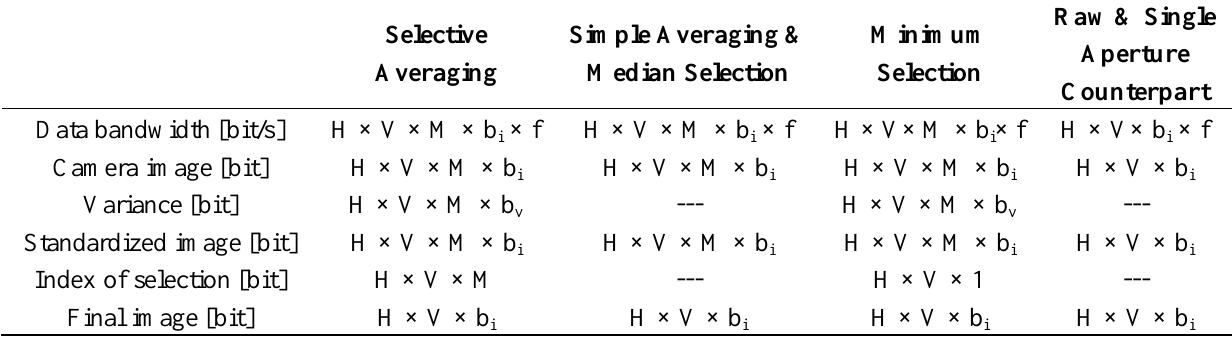
Table 3. The data bandwidth and required memory size of frame